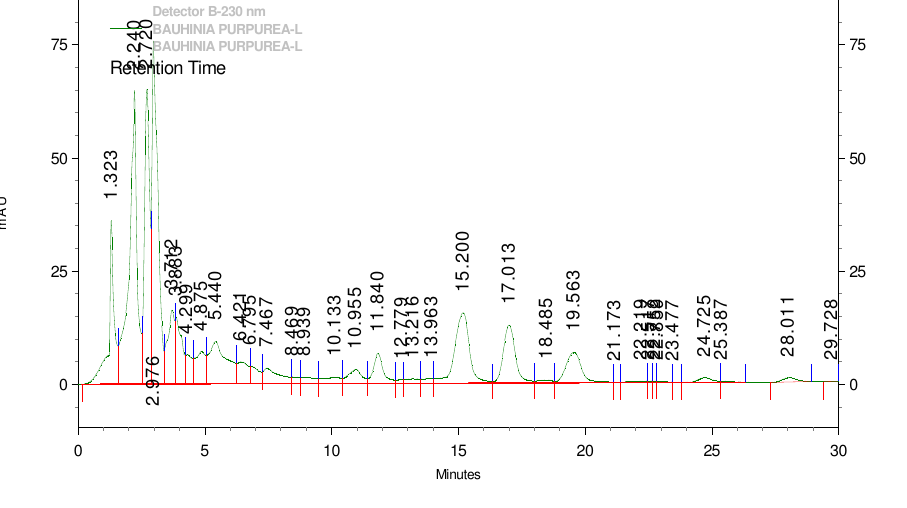
Figure 2 . HPLC finger print profile of ethanolic extract of Bauhinia purpurea